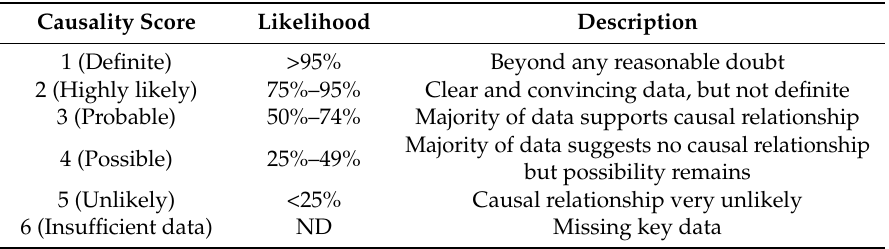
Table 1. Drug-Induced Liver Injury Network scoring